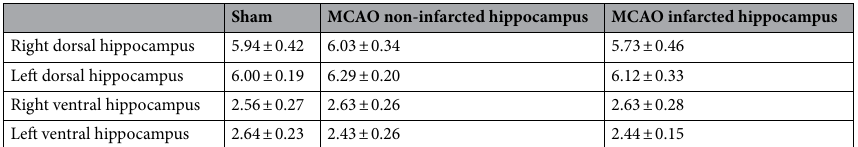
Table 1. Dorsal and ventral hippocampal volumes (mm 3 ) at baseline (mean ± s.d.).